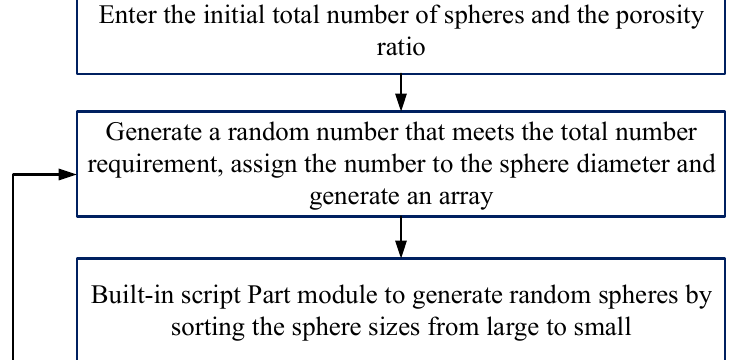
Figure 1. Model building flowchart.